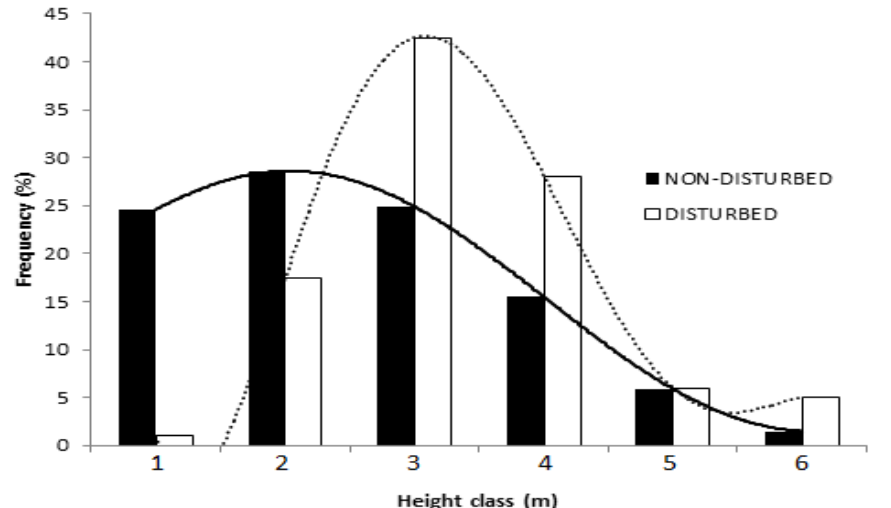
Figure 6. Weibull distribution for the tree height of B. aegyptiaca in the non-disturbed and disturbed sites at the Dinder Biosphere Reserve, Sudan, along increasing height categories. Classes: 1 = 3–5 m,